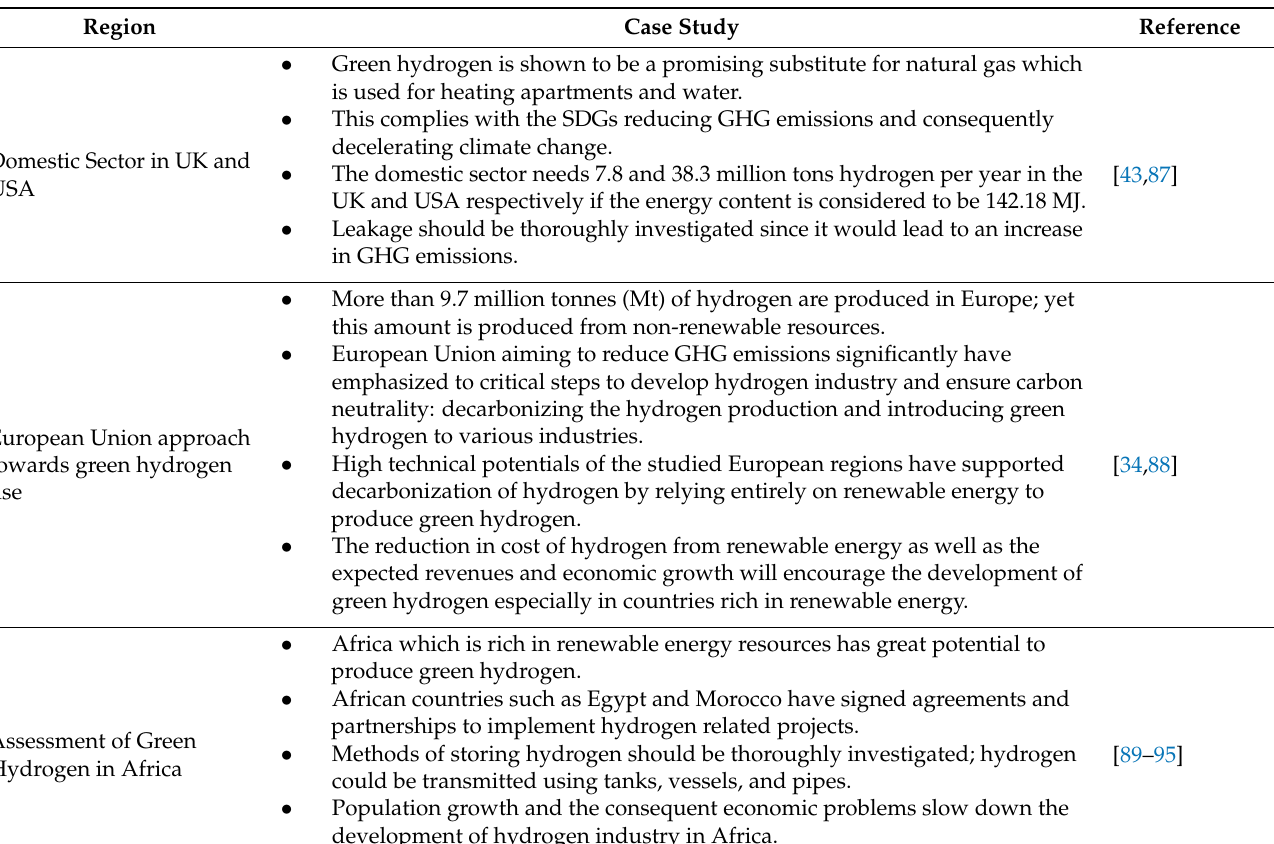
Table 2. Case Studies of green